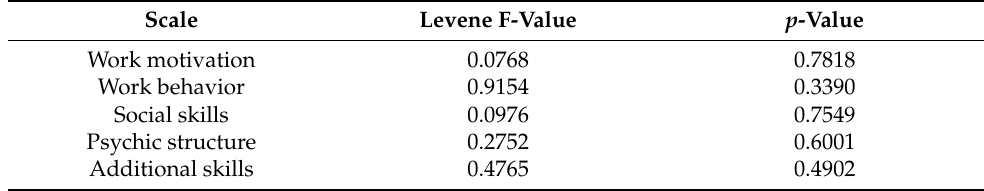
Table 22. Levene test statistics when the sample is differentiated by the tenure of the university. Scale Levene F-Value p -Value Work